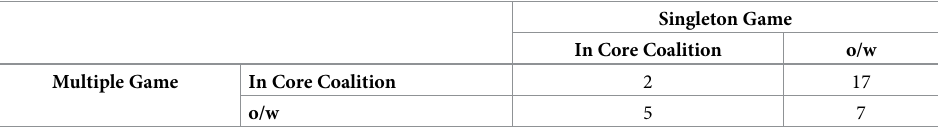
Table 8. Contingency table of results from